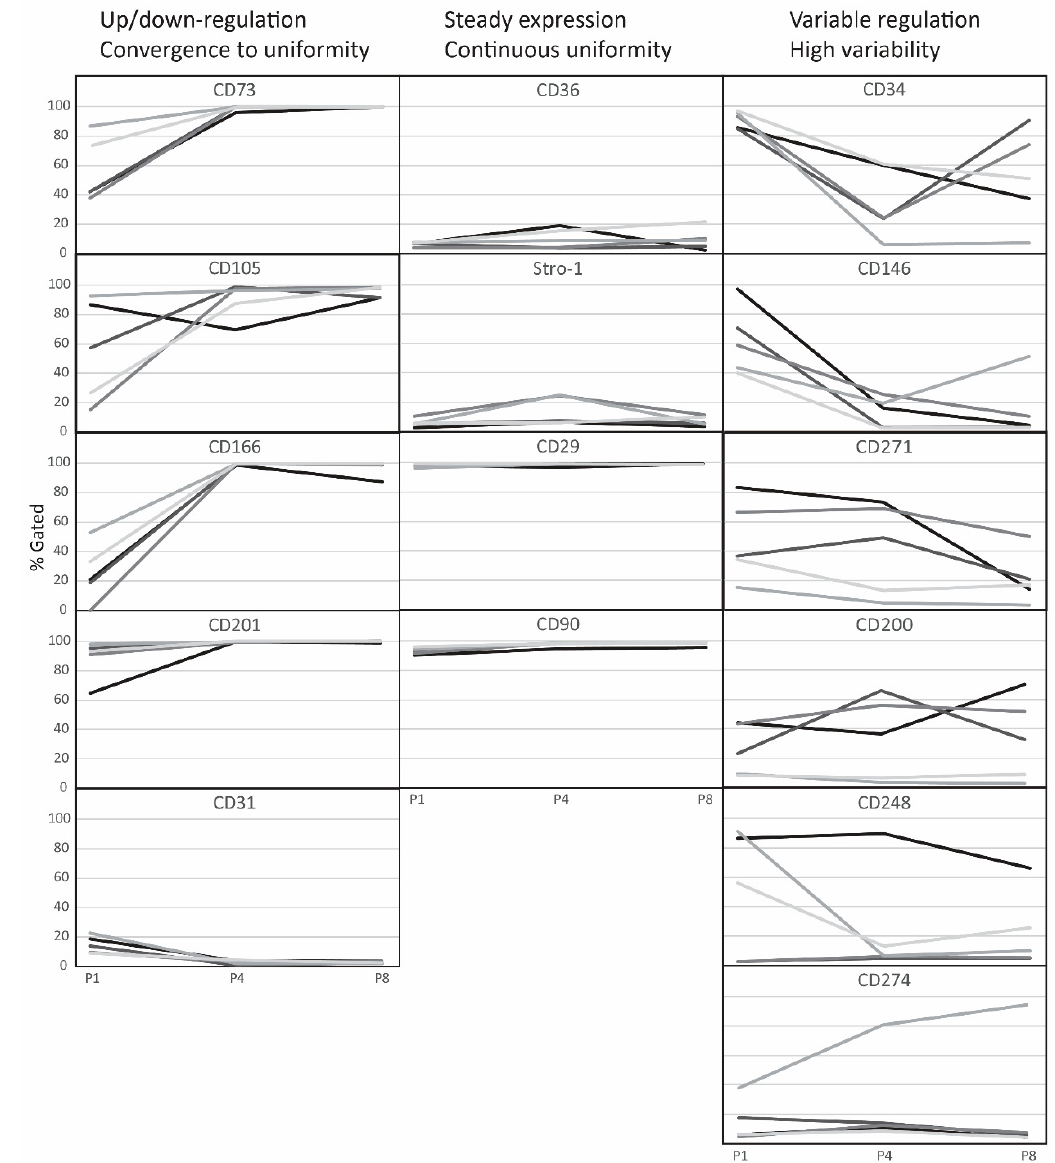
Figure 3. Kinetic profiles of single-marker expression across population expansion. Traces from 5 donors are shown at passages P1, P4, and P8. CD; cluster of differentiation, P; passage.